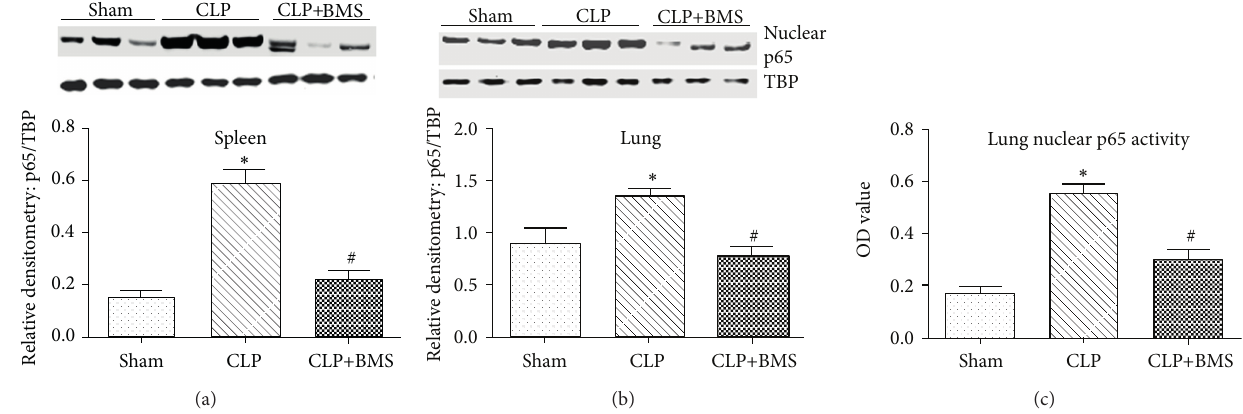
Figure 1: Treatment with the IKK inhibitor (BMS-345541) inhibits NF- 𝜅 B activation after CLP. Nuclear protein extracts from (a) spleen and (b)lungtissuewereprobedforp65(RelA)bywesternblot.Densitometryshowsp65banddensitynormalizedbyTATAbindingprotein(TBP). ANOVA test was used for comparison among multiple groups. Tukey post hoc tests were undertaken after ANOVA. There were significant differences for CLP versus sham or CLP+BMS mice ( ∗ 𝑃 < 0.05 for CLP versus Ctrl, # 𝑃 < 0.05 for CLP+BMS versus CLP), while there was no significant difference between sham and CLP+BMS mice. (c) Lung NF- 𝜅 B DNA binding activity was also assessed in nuclear protein extracts by TransAM ELISA. ANOVA test was used for comparison among multiple groups. Tukey post hoc tests were undertaken after ANOVA. There were significant differences for CLP versus sham or CLP+BMS mice ( ∗ 𝑃 < 0.05 for CLP versus Ctrl, # 𝑃 < 0.05 for CLP+BMS versus CLP), while there was no significant difference between sham and CLP+BMS mice. Results are presented as mean ± SE, 𝑁 = 3 per group. Each experiment was repeated three